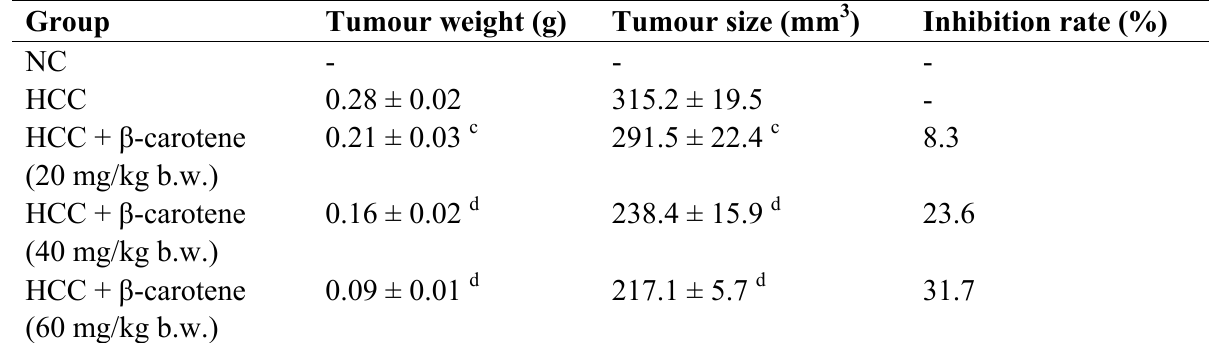
Table 1. Effect of β -carotene on tumour weight, size and inhibition rate.